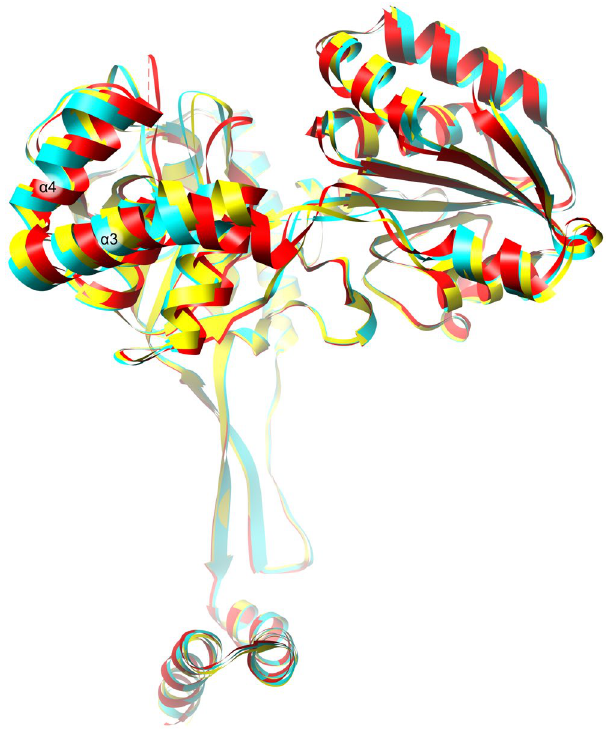
Figure 7. Superposition of the three states of Mt HDH: Mt HDH/IMD complex, yellow; Mt HDH/HOL, cyan; Mt HDH/His/NAD + ,